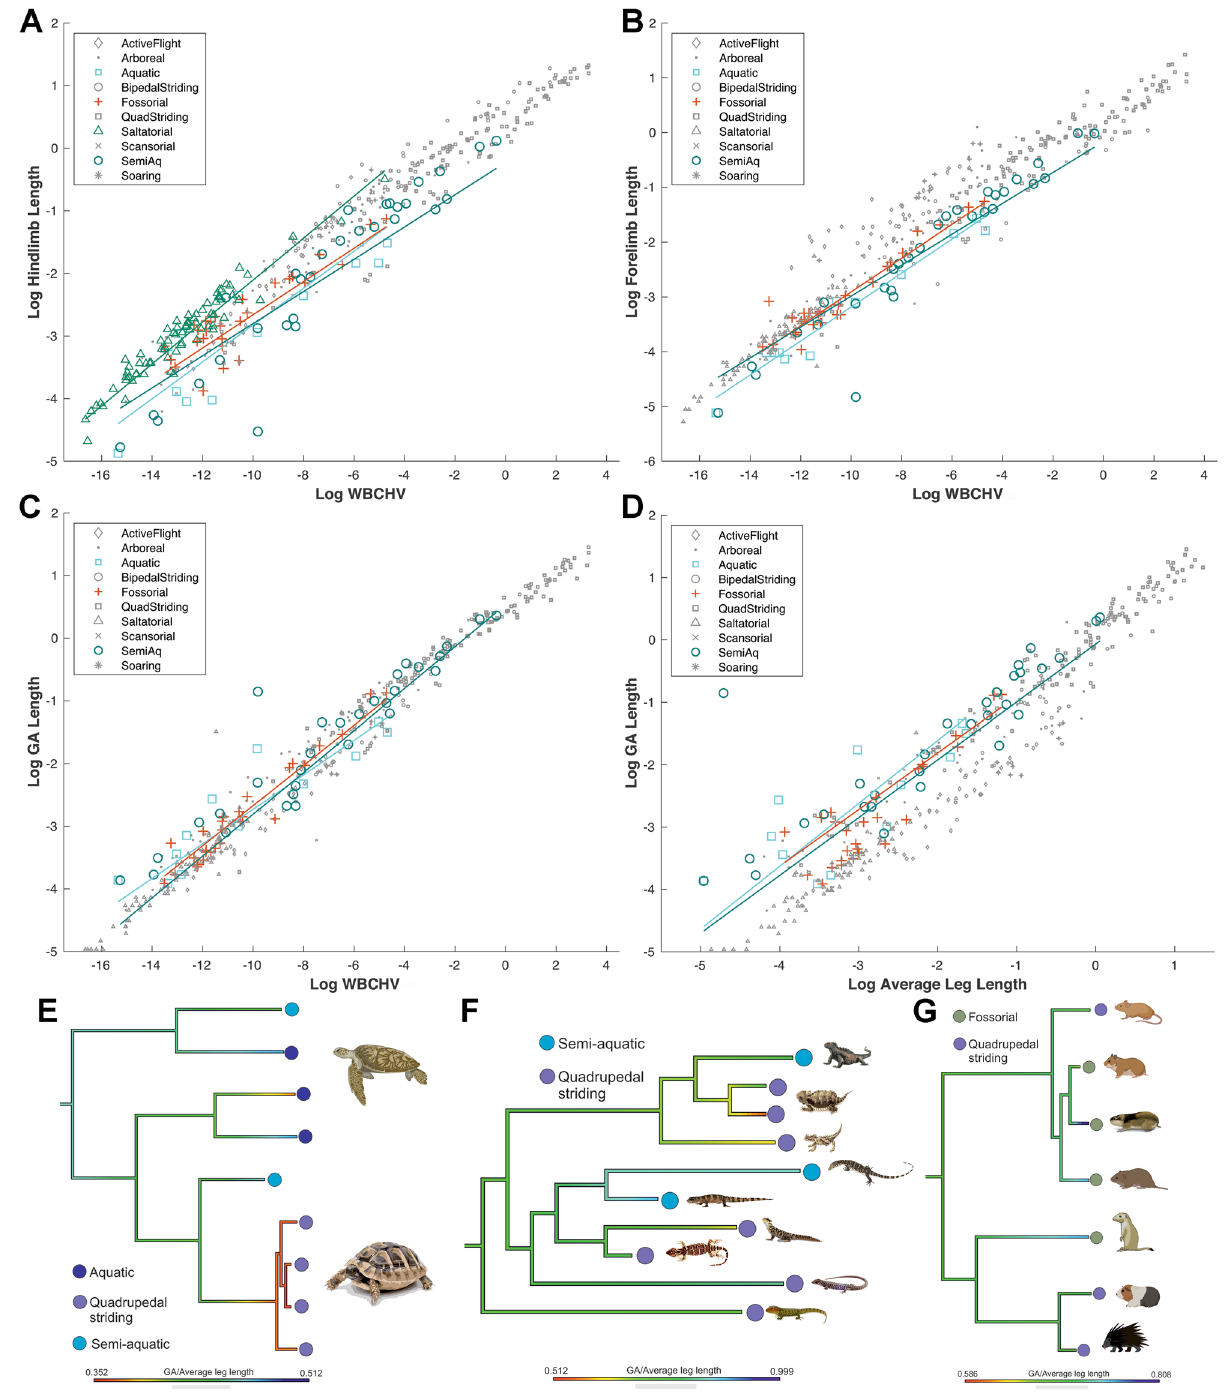
limbs and an elongate torso can be seen within major taxonomic sub-groups that contain aquatic, semi-aquatic and fossorial species, including E Testudines (turtles and tortoises), F lizards and G rodents. WBCHV, whole-body convex hull volume. Source data are provided as a Source Data fi le. Animal images created with